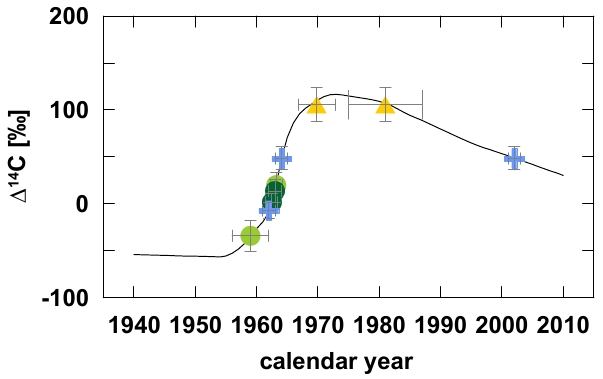
Fig. 4. Modelled Black Sea surface water DIC 1 14 C history. As example, potential calendar years of pigment synthesis derived from correlation with 1 14 C concentrations are given for station P167. Error bars denote 1 σ analytical uncertainties. Chl- a : chlorophyll- a , Phe- a : pheophytin- a , PPhe- a : pyropheophytin- a , Cyclo: 13 2 ,17 3 - cyclopheophorbide- a